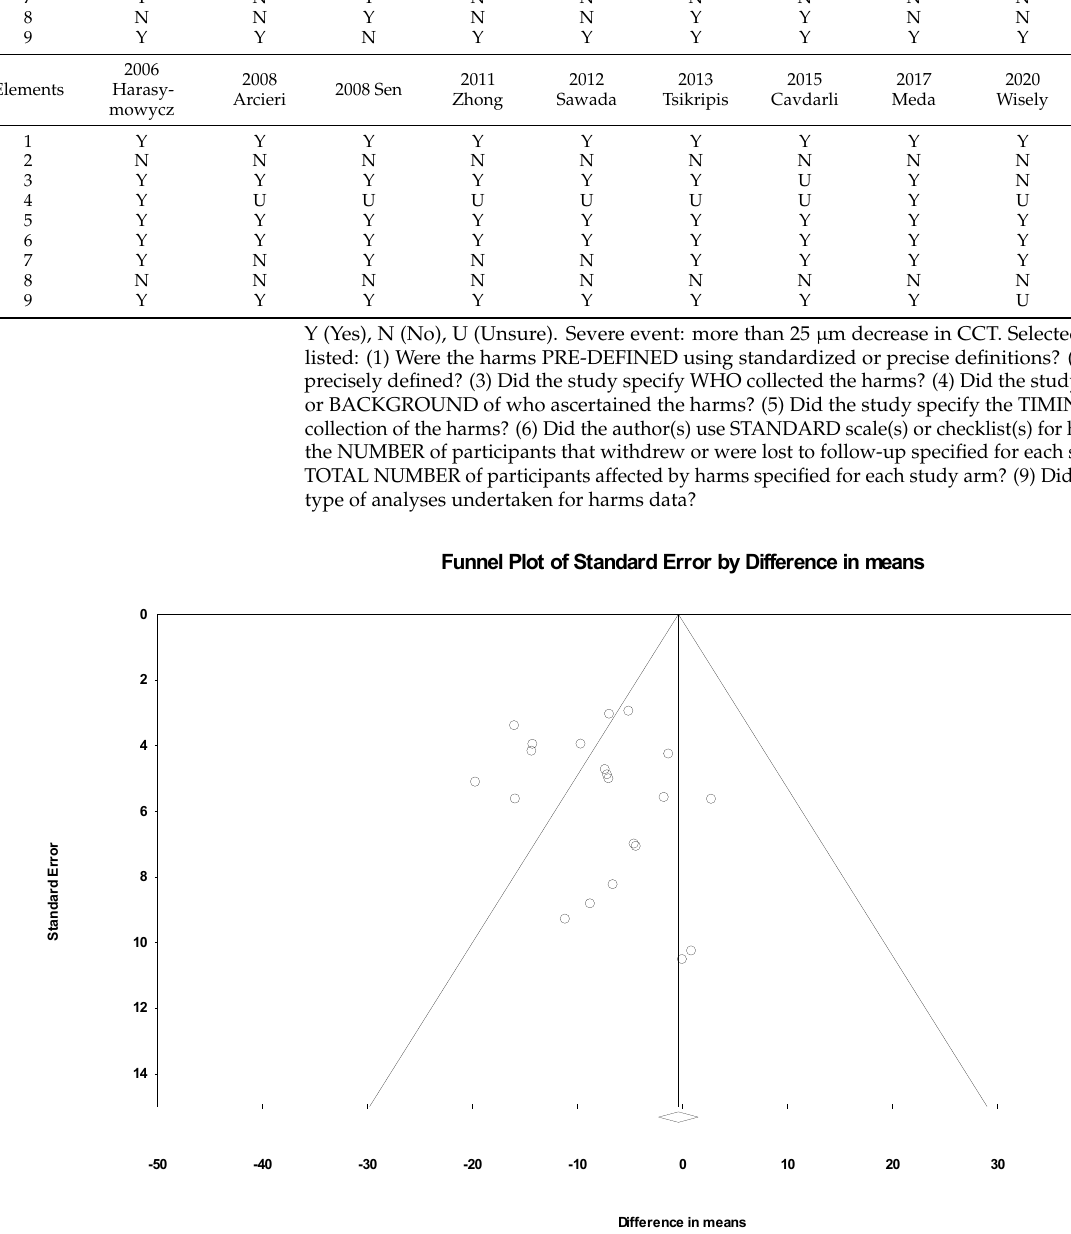
Figure A1. Funnel plot for publication bias for 22 prospective studies.